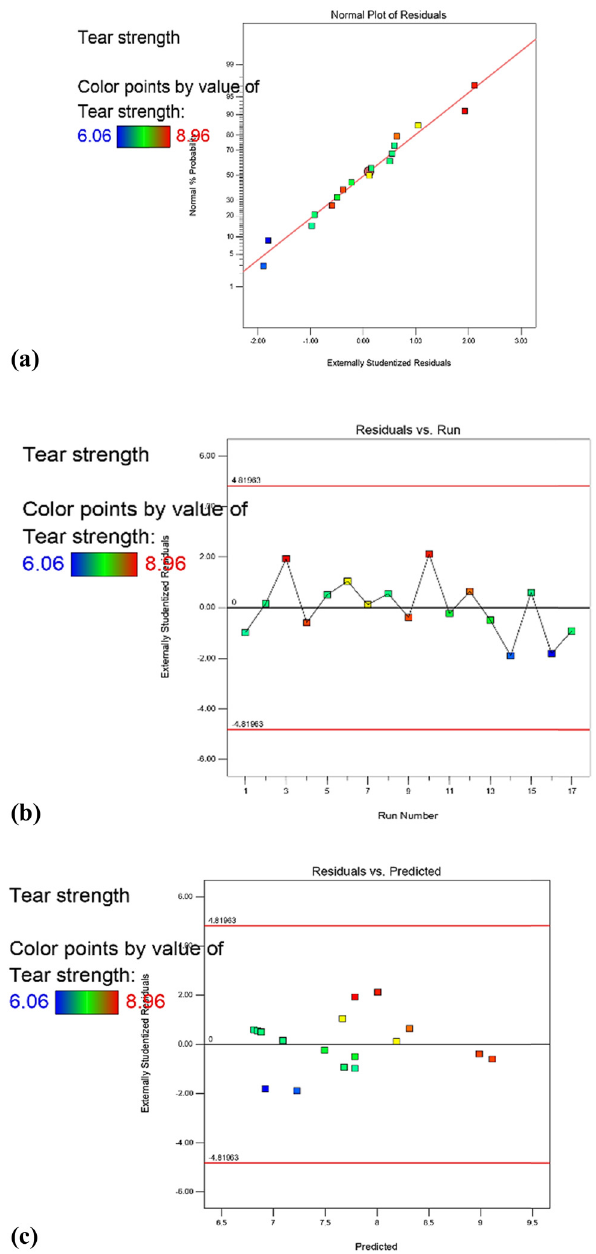
Figure 18: ( a ) Normal percent probability graph for tear strength. ( b ) Residual vs predicted graph for tear strength. ( c ) Residual vs run graph for tear